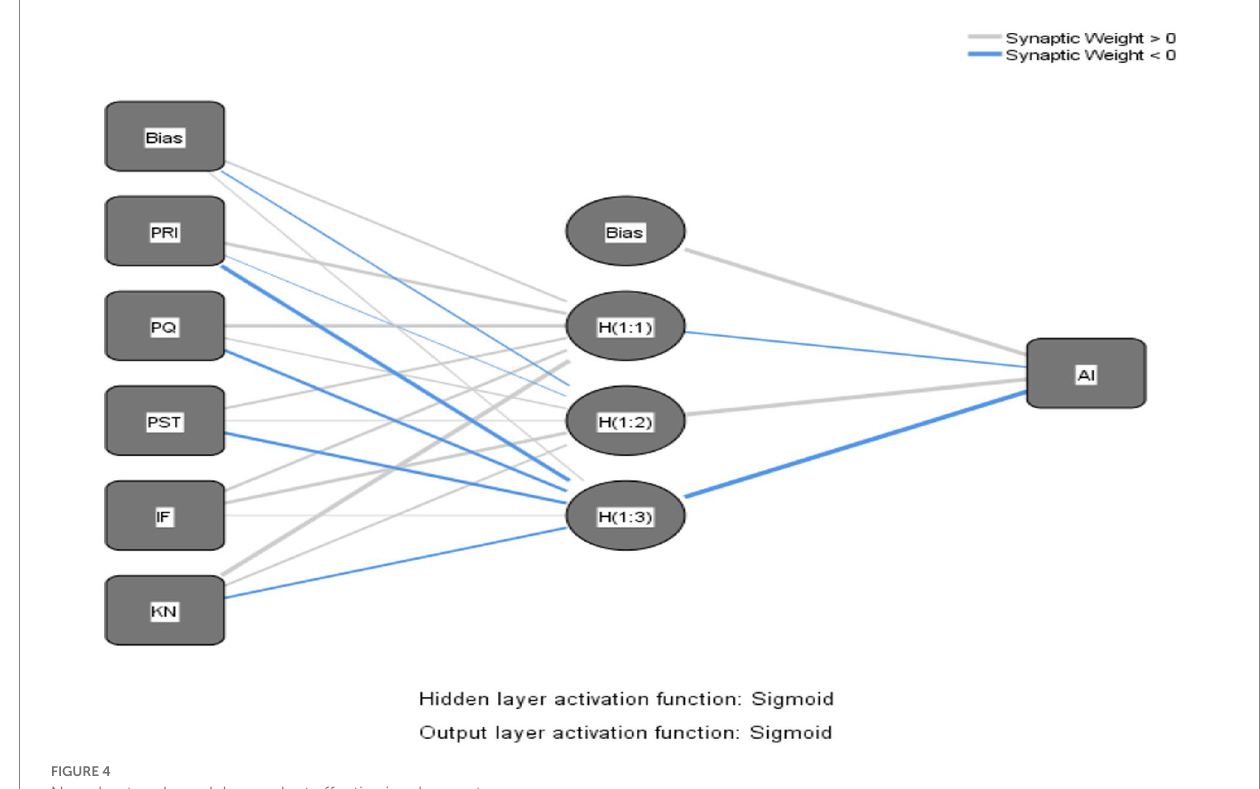
FIGURE 4 Neural network model – product affective